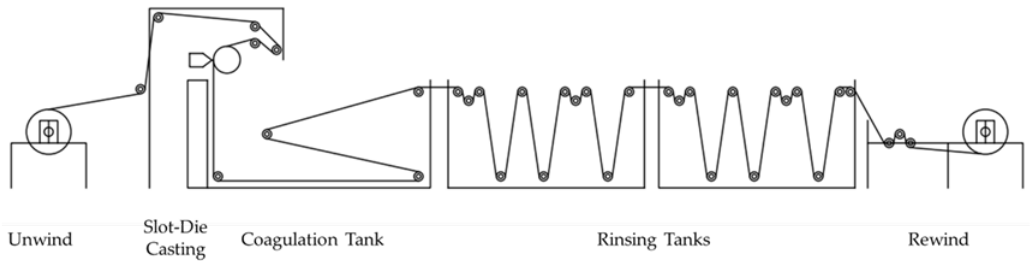
Figure 1. Schematic diagram of the pilot-scale phase-inversion casting line used in this study.